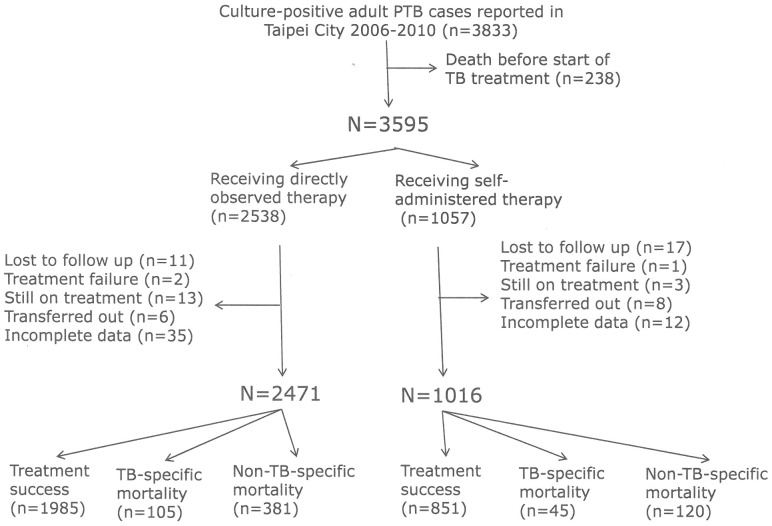
Study flow diagram.PTB, pulmonary tuberculosis.